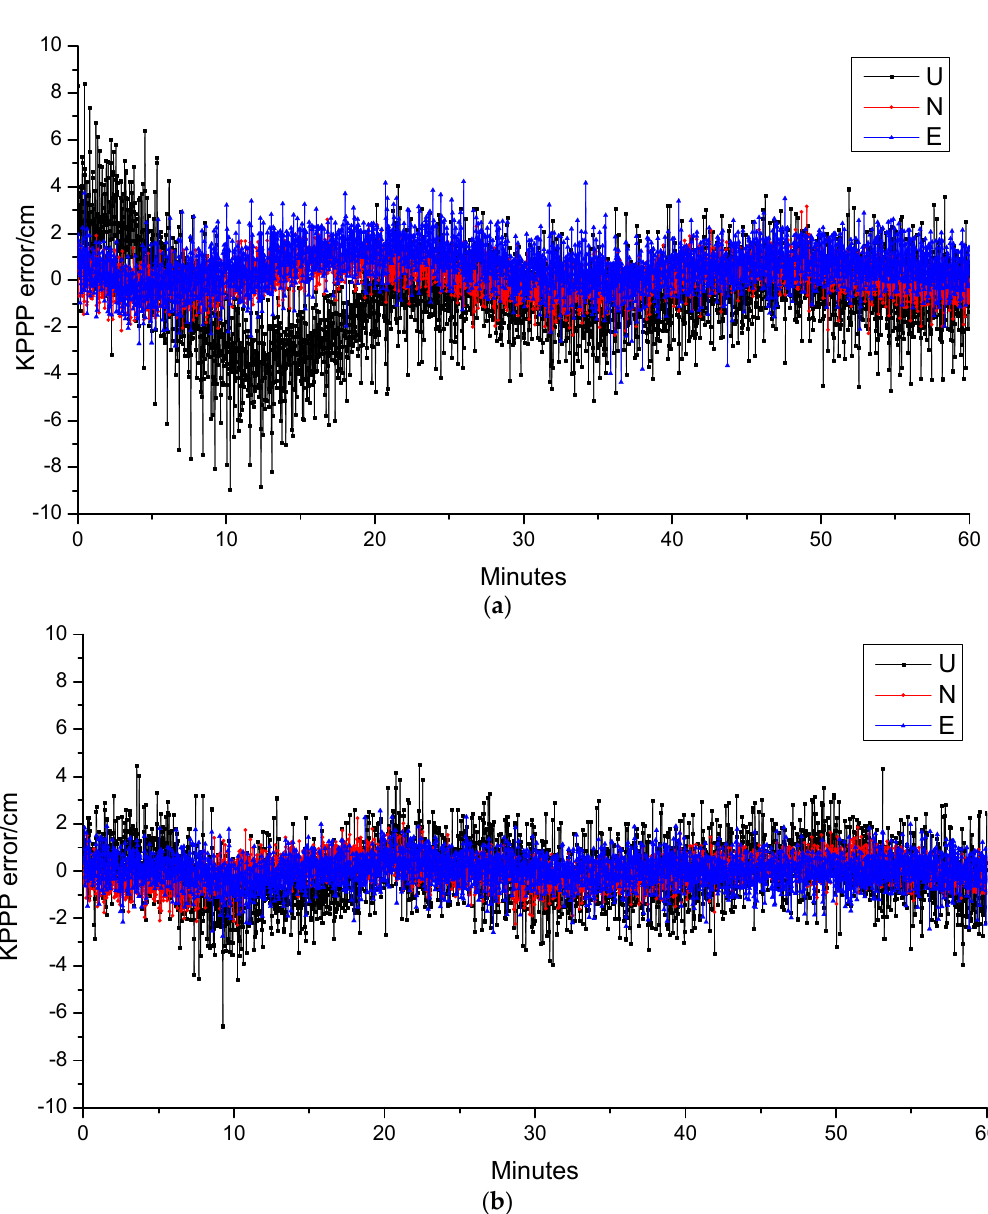
Figure 6. Time series of kinematic PPP positioning errors of CENT station in 1 h after the convergence of PPP for BeiDou-3 ( a ) and BeiDou-3 as well as LEO combined solutions ( b ), respectively.